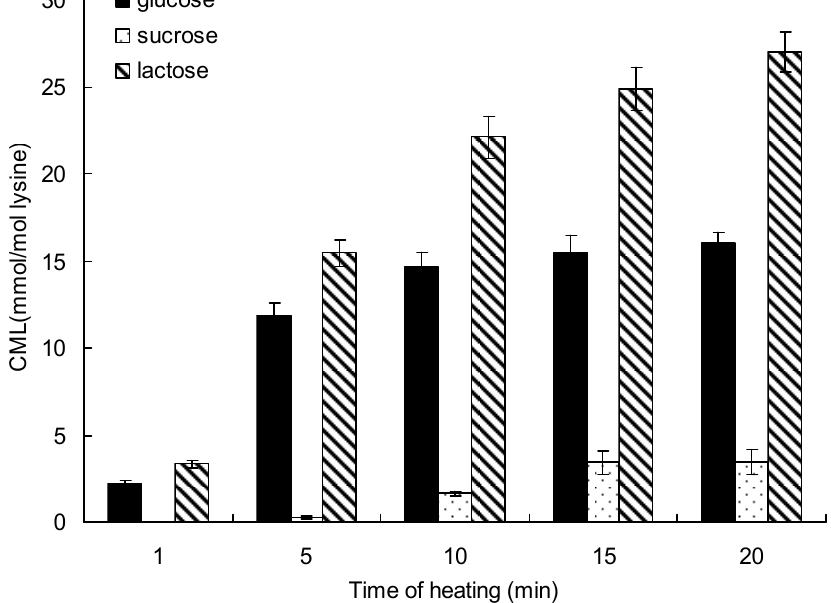
Figure 4. Formation of CML in saccharide-lysine over time. Data points are the mean of triplicate measurements ±